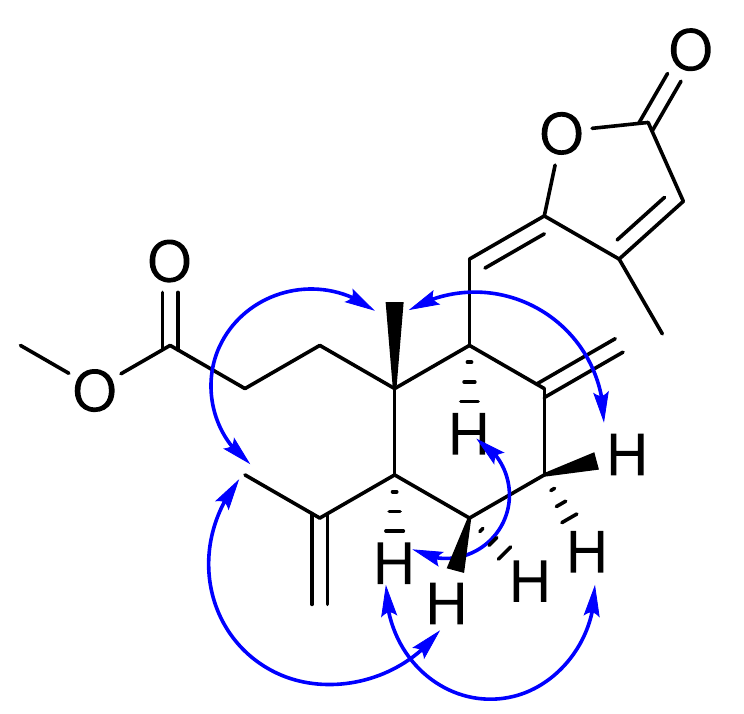
Figure 3. Key NOESY correlations of 1 .